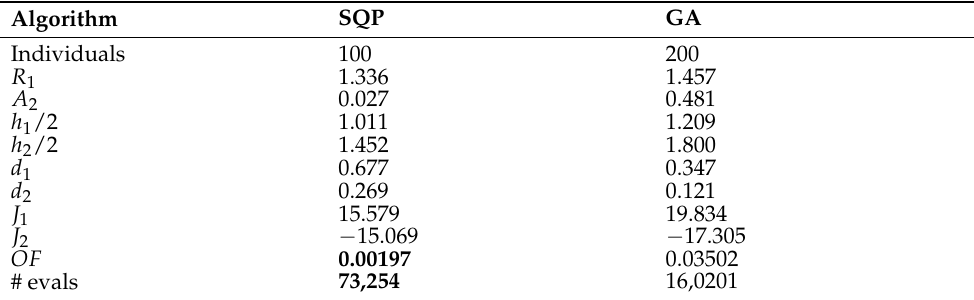
Table 5. TEAM Workshop Problem 22 optimization